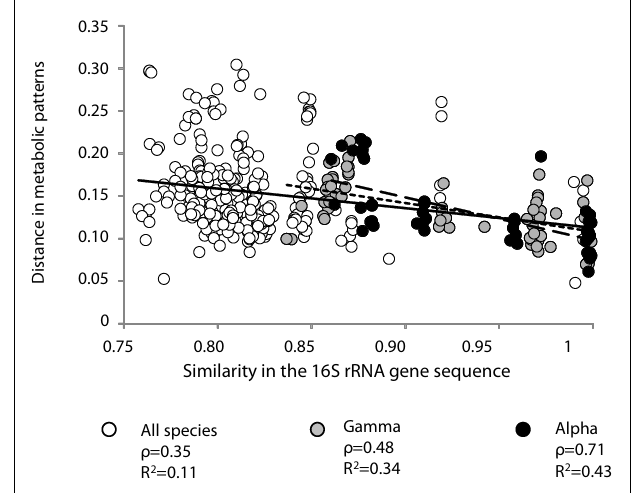
FIGURE 3 | Pairwise comparisons of the distance in metabolic patterns and similarity between 16S rRNA gene sequence for ( ) the 29 denitrifying bacterial strains, and among denitrifying bacteria from ( ) α - and ( ) γ -proteobacteria classes. Metabolic profiles were determined based on carbon utilization patterns on 95 carbon sources under denitrifying conditions (BIOLOG). Comparisons were performed using a non-parametric form of Mantel test and Spearman coefficient ( ρ ). Significance level was checked using a permutation test (5000 permutations). Linear regression lines are also indicated on the graph with associated r 2 values. All correlations were significant ( P <